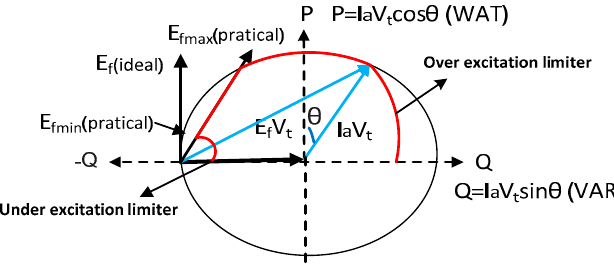
Figure 5. The operation zone of the PV bus capability curve.